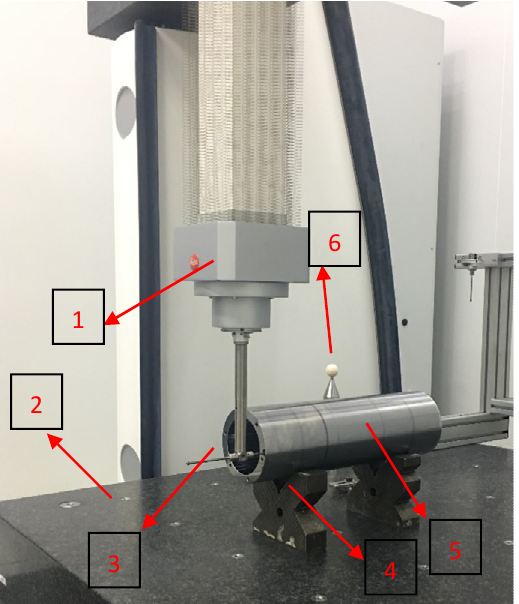
Figure 7. Inspection site of motorized spindle. 1—telescopic probe; 2—workbench; 3—probe; 4—V block; 5—motorized spindle part; 6—school team coordinate system.